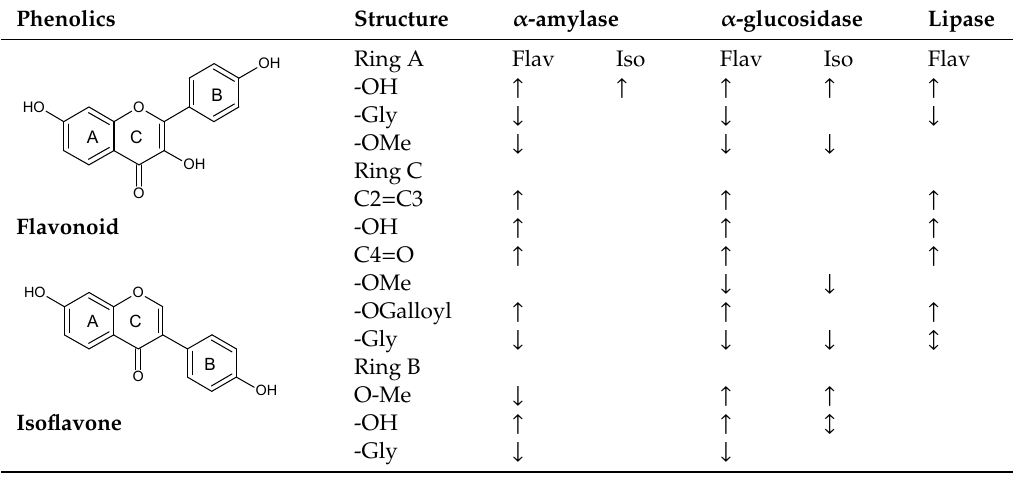
Flav: Flavonoid. Iso: Isoflavone. -Gly: Glycosylation. -OGalloyl: attachment of a galloyl moiety to the hydroxyl group. ↑ increase in enzymatic inhibition. ↓ decrease in enzymatic inhibition. ↕ No systematic effect; it can increase or decrease the inhibitory activity depending on the flavonoid.